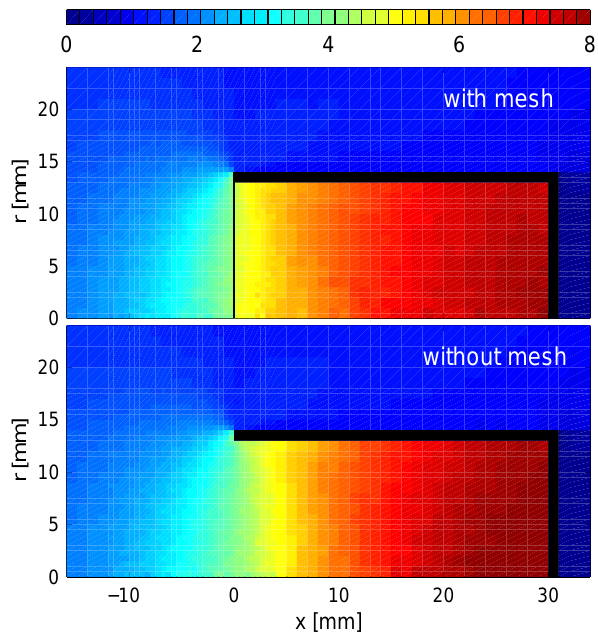
Fig. 8. As Fig. 6, but for the more rarefied atmospheric flow con- ditions representative for an altitude of ∼ 100 km: p ∞ = 0 . 03 Pa, c ∞ = 800 ms − 1 and T ∞ = 180